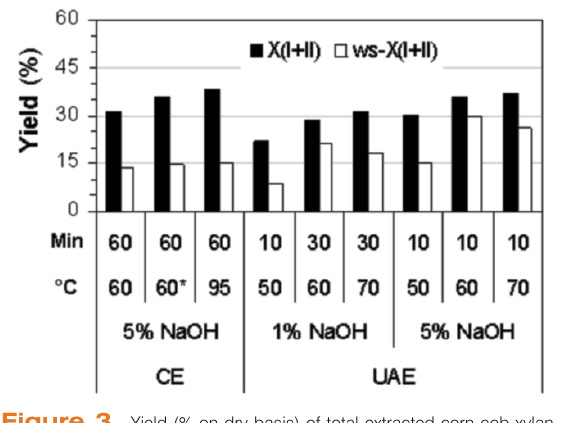
Figure 3. Yield (% on dry basis) of total extracted corn cob xylan X(I+II) and its water-soluble fraction ws-X(I+II) obtained by classical (CE) and ultrasound-assisted (UAE) extractions. O . * Added 2% H 2 2